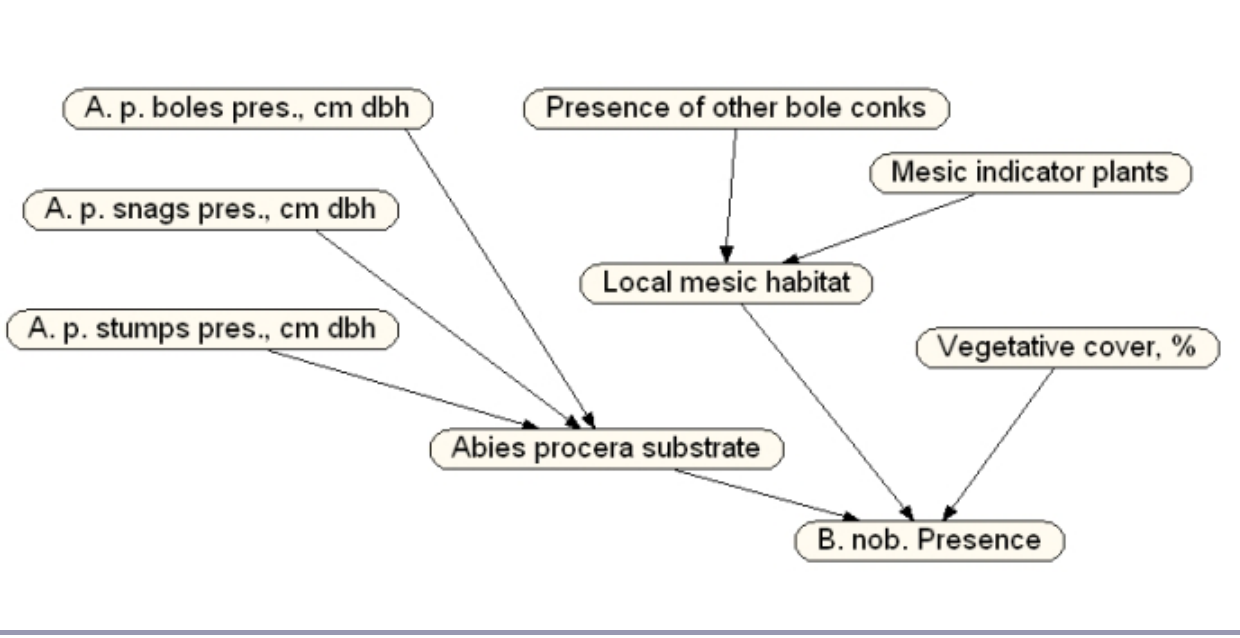
Fig. 2. A simple influence diagram showing key environmental correlates of presence of a rare fungus, Bridgeoporus nobilissimus (B. nob.). Best used as the basis for further modeling, the correlates should also express causal relations, so that the diagram becomes a “causal web.” A. p. = Abies procera (noble fir), pres. = present, dbh = diameter at breast